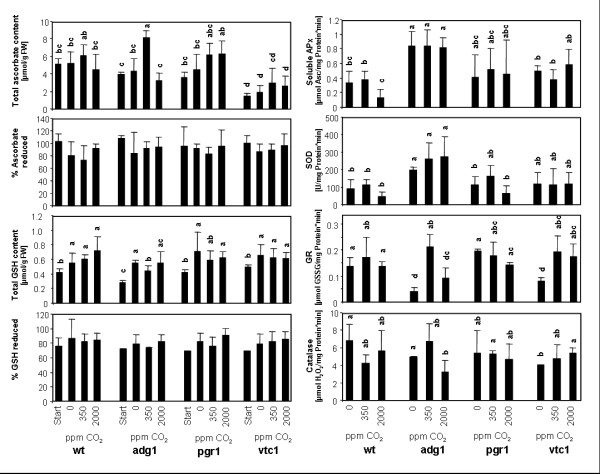
Redox stabilization and antioxidant defense in response to differing CO2 availability: Content of total antioxidant amount and reduction status (ascorbate and glutathione) and activities of selected antioxidative enzymes: total soluble ascorbate peroxidases (APx), total soluble superoxide dismutases (SOD), glutathione reductase (GR) and catalases (CAT) in wt, adg1, pgr1 and vtc1 under different CO2 regimes (0 ppm, 350 ppm and 2000 ppm CO2) measured in aqueous extracts. The data are means of n = 4–6, ± SE from at least 4 different experiments.